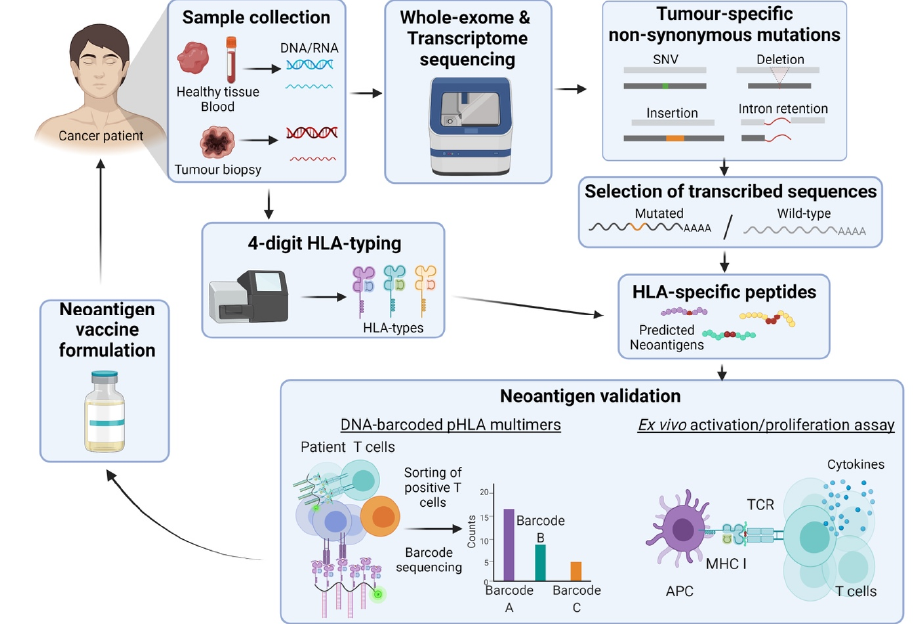
Figure 1. Basic neoantigen vaccine pipeline. 1. Sample collection. Tumour biopsy and healthy tissue from blood or the surrounding area of the lesion are the starting material for DNA and RNA extraction. 2. Whole exome and transcriptome sequencing. DNA and RNA are used to sequence the whole-exome and transcriptome of the healthy and tumour samples. 3. Tumour-specific non-synonymous mutations. Exome data is processed, and tumour non-synonymous mutations derived from different mutational sources are annotated using specialized packages, such as GATK, VarScan2, FACTERA and ANNOVAR [148–151]. Comparison of these mutations with the corresponding healthy tissue sequence will pinpoint somatic mutations restricted to the tumour. 4. Selection of transcribed sequences. One of the most important